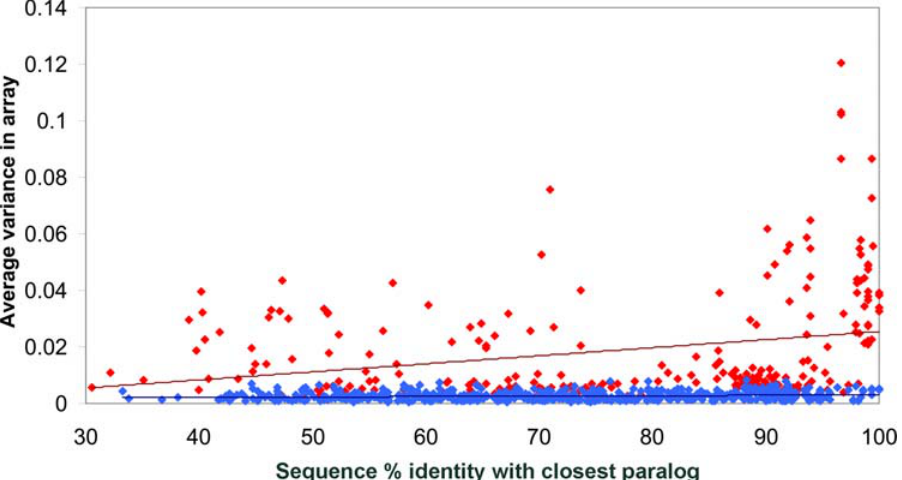
Figure 3. Correlation of OR copy-number variability with paralog-similarity. Red and blue dots indicate copy-number variable and non- variable ORs, respectively (copy-number variability is expressed in terms of the measure R , see Methods, which we found to correlate well with gene dosage). Percentage DNA sequence identity (‘‘% identity’’) to the closest paralog in the human genome is plotted versus the array-based (i.e., R - measure-based) variance. Correlation for ORs affected by CNVs is C=0.26 (P value =10 2 5 ), whereas for non-variable ORs it is C=0.15 (P value =10 2 4 ). Linear regression fits for each dataset are indicated with red and blue dashed lines, respectively.